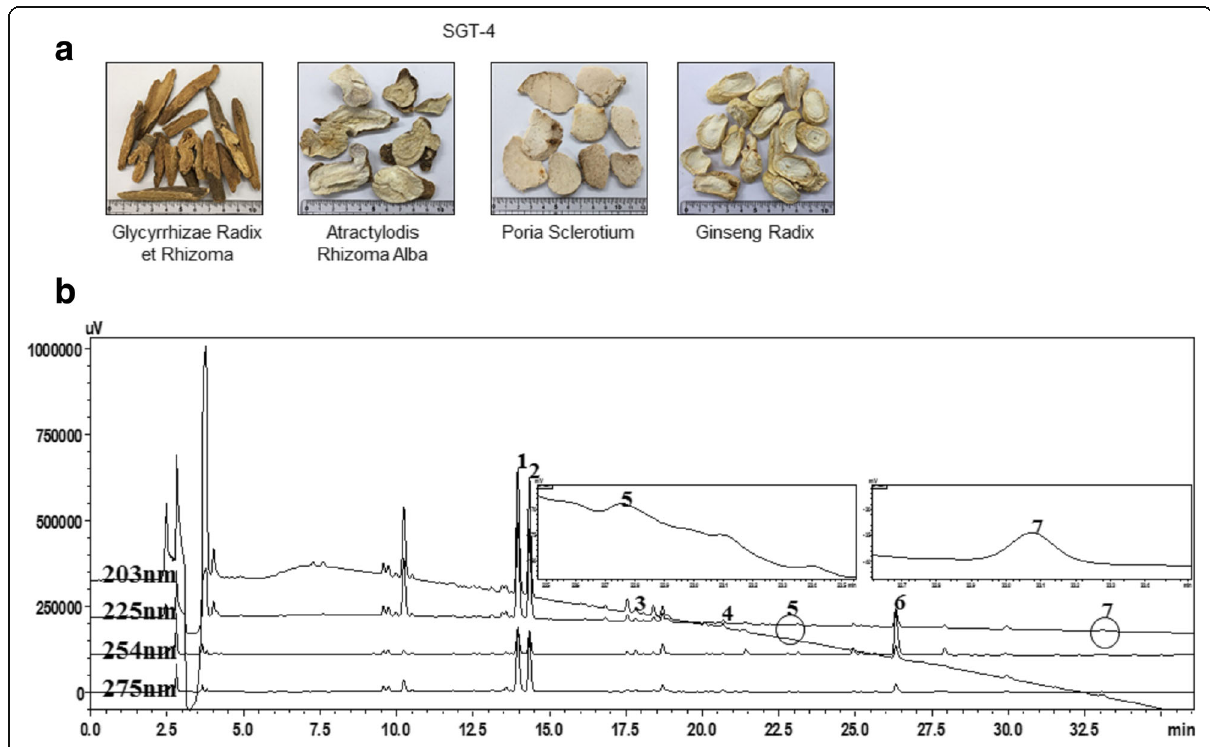
Fig. 1 Composition of Sagunja-tang (SGT-4) and HPLC analysis of the SGT-4 decoction. a The SGT-4 extract was mixed from the four medicinal herbs (Ginseng Radix, Glycyrrhizae Radix et Rhizoma, Atractylodis Rhizoma Alba, and Poria Sclerotium ) b The retention times of the 7 marker compounds- liguiritin apioside, liquiritin, ginsenoside Rg1, ginsenoside Rb1, glycyrrhizin, liquiritigenin, and atracetylenolide